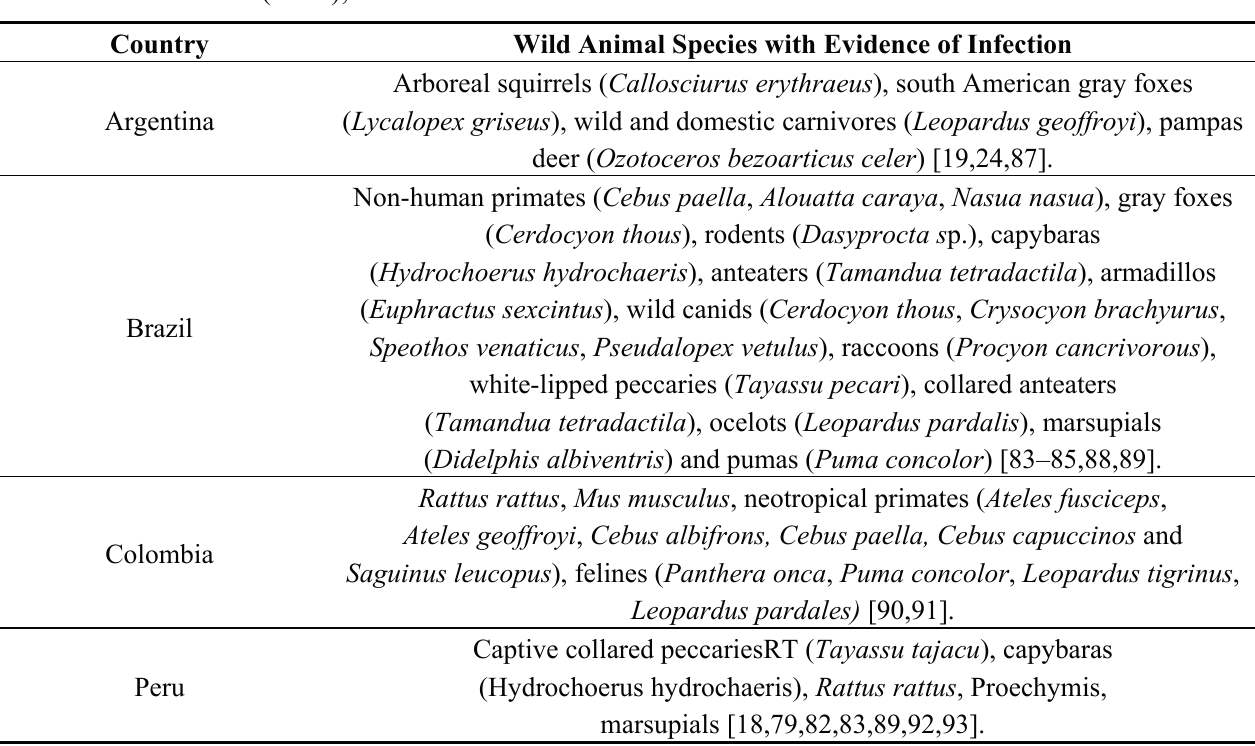
Table 2. Wild animals showing evidence of Leptospira infection by country in Latin America and Caribbean (LAC),